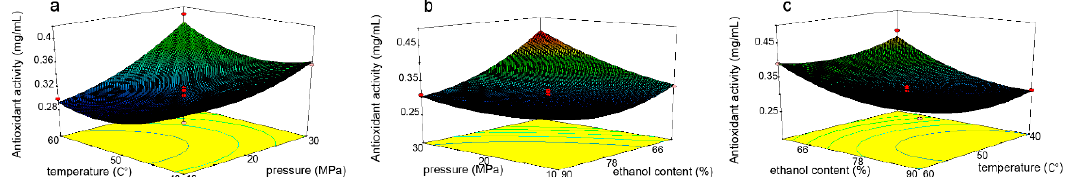
Figure 5. Response surface and contour plots of antioxidant activity showing ( a ) the effect of pressure and temperature at constant 75% ethanol concentration; ( b ) the effect of pressure and ethanol content at constant temperature 50 °C; ( c ) the effect of temperature and ethanol content at constant pressure 20 Mpa.